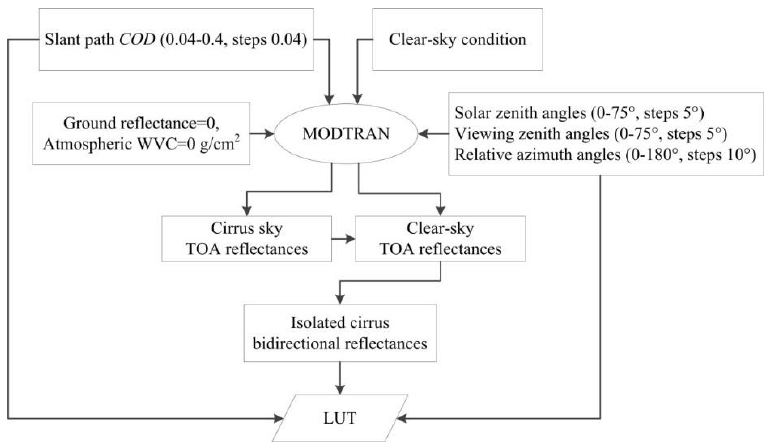
Figure 4. Procedure for the generation of the ICBR